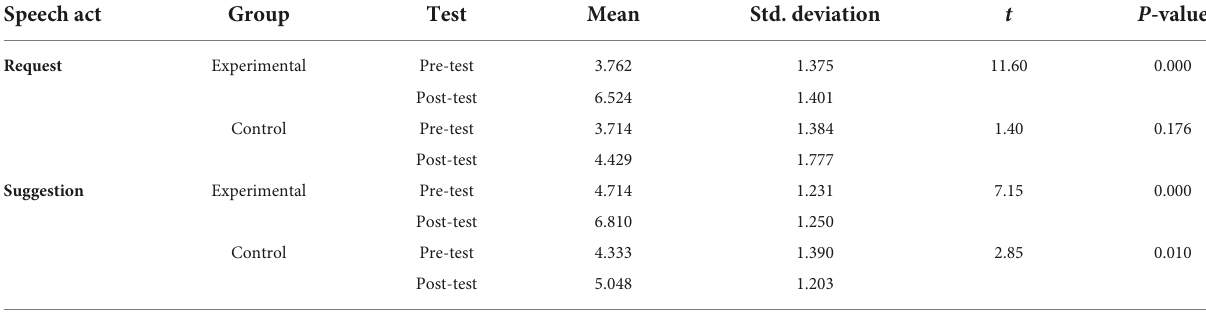
TABLE 8 Paired-samples t -test for the experimental and control